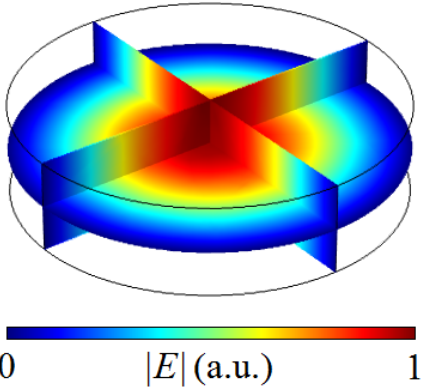
Figure 1. The amplitude of the electric field | E | of the fundamental resonant mode (TM 010 ) in a cylindrical resonant